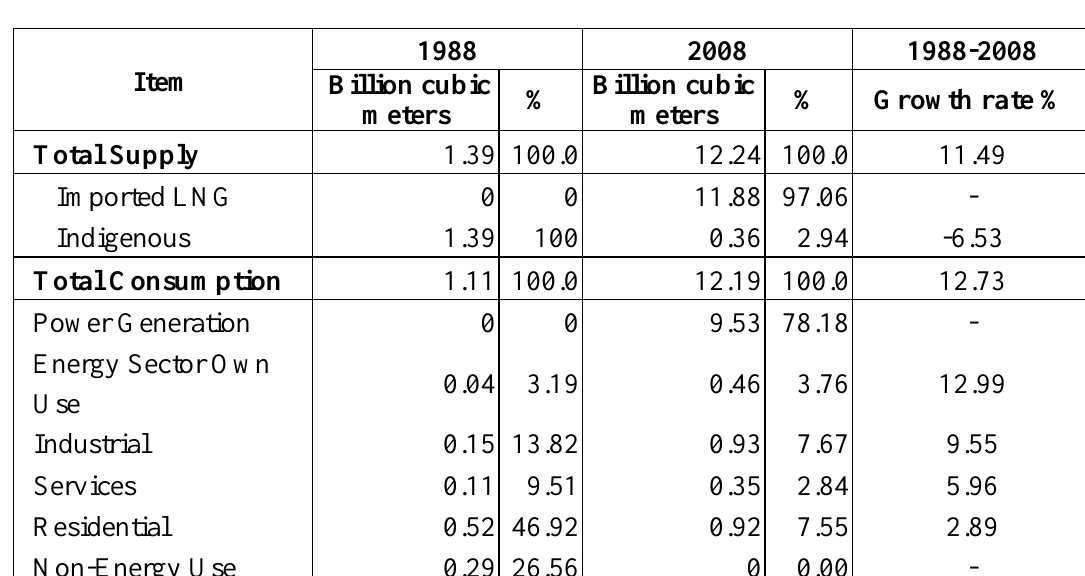
Table 4. Natural gas supply and consumption